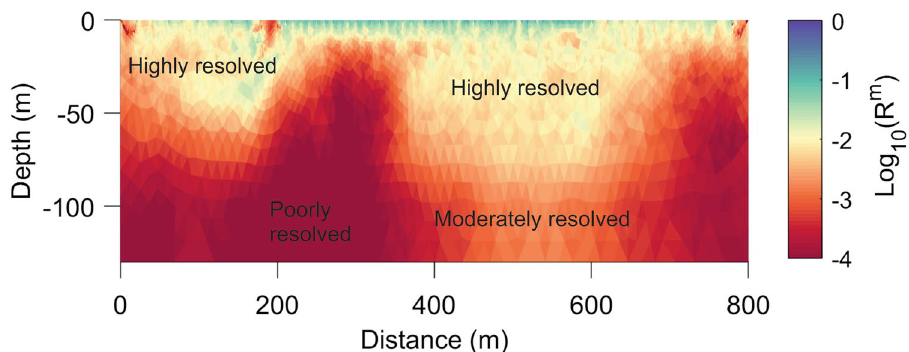
Figure 2. Diagonal elements of the model resolution matrix for the inverted resistivity model